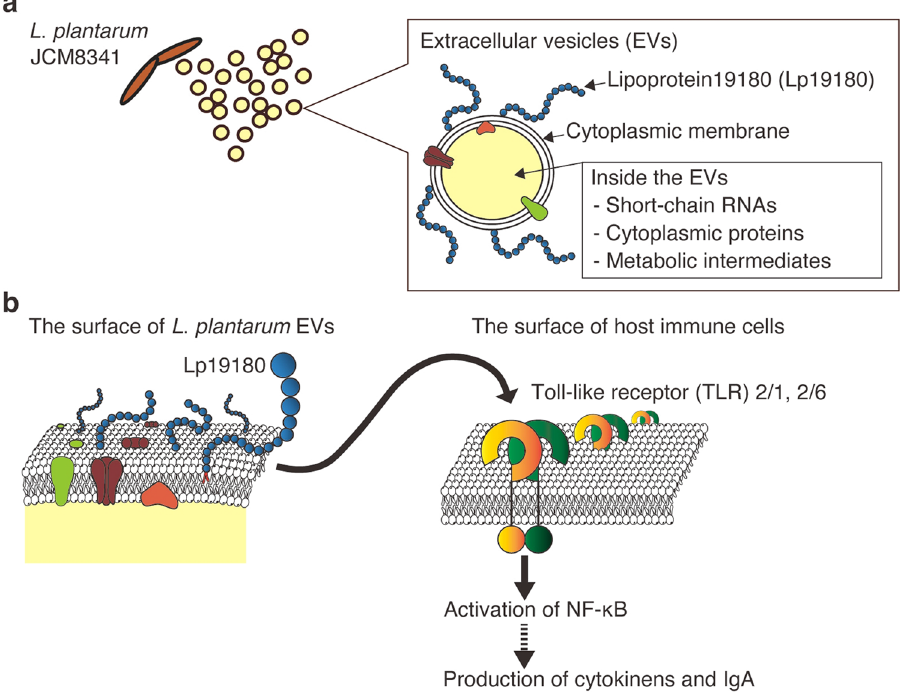
Figure 1. Properties of EVs produced by L . plantarum and their effects on host immune cells. ( a ) Biochemical components of L . plantarum EVs. ( b ) Schematic sketch of NF-κB activation by Lp19180 via TLR2 and the subsequent stimulation of innate and adaptive